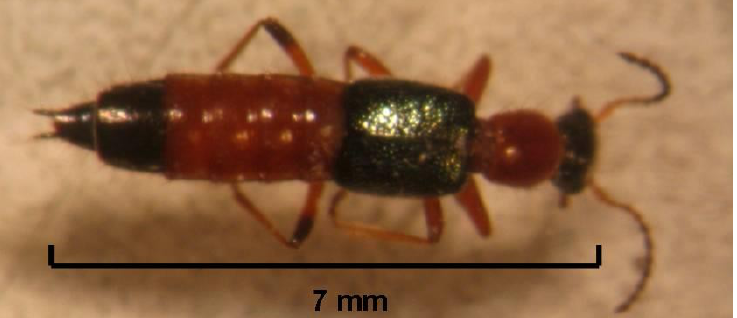
Figure 10. Paederus iliensis , the only recorded species of Noor-Abad and Kazeroon counties, Fars province, southern